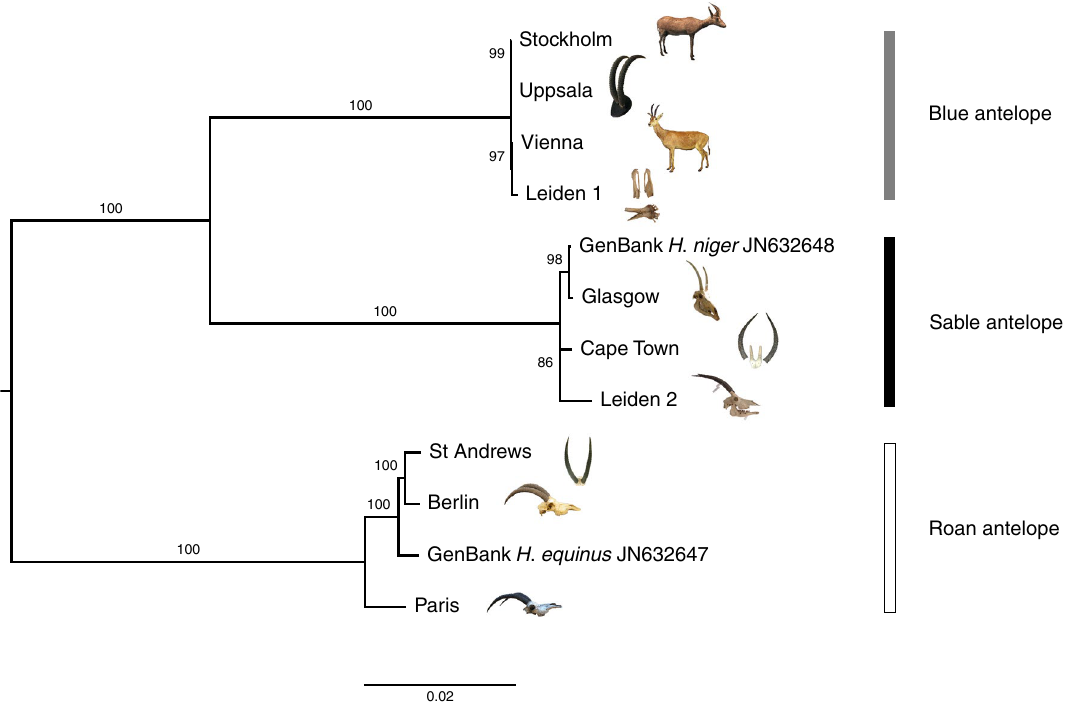
Figure 3. Clustering of samples in a maximum-likelihood phylogeny. Maximum-likelihood tree based on the mitochondrial genome alignment excluding the control region (15,450 bp in length) using the reference with the highest mapping success for each sample. The tree shows three clades (100% bootstrap support each) in agreement with the three Hippotragus species (black: sable, white: roan, grey: blue antelope), confirming the species assignments from the mapping results. RAxML 8.2.10 with GTR + G 56 was used to generate the phylogeny. Branch values indicate bootstrap support of 100 replicates. Ovis aries musimon (HM236184) 55 was used as outgroup (not shown here). Photo credits: see Fig.